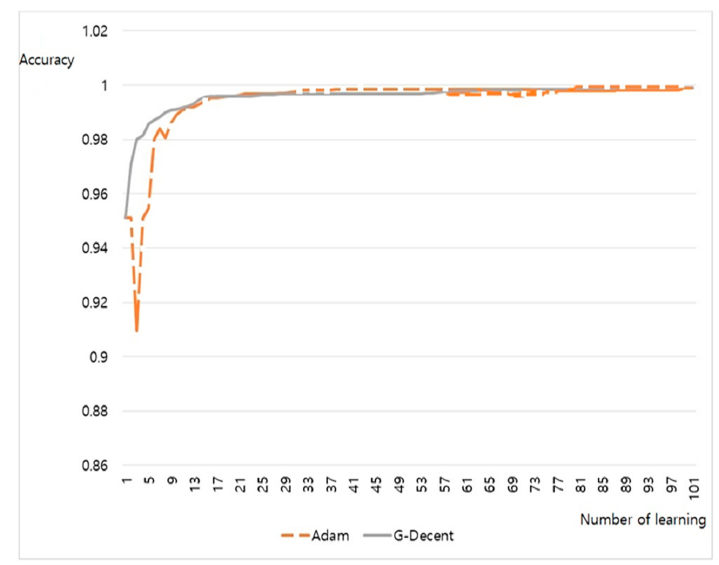
Figure 14. Accuracy comparison graph.